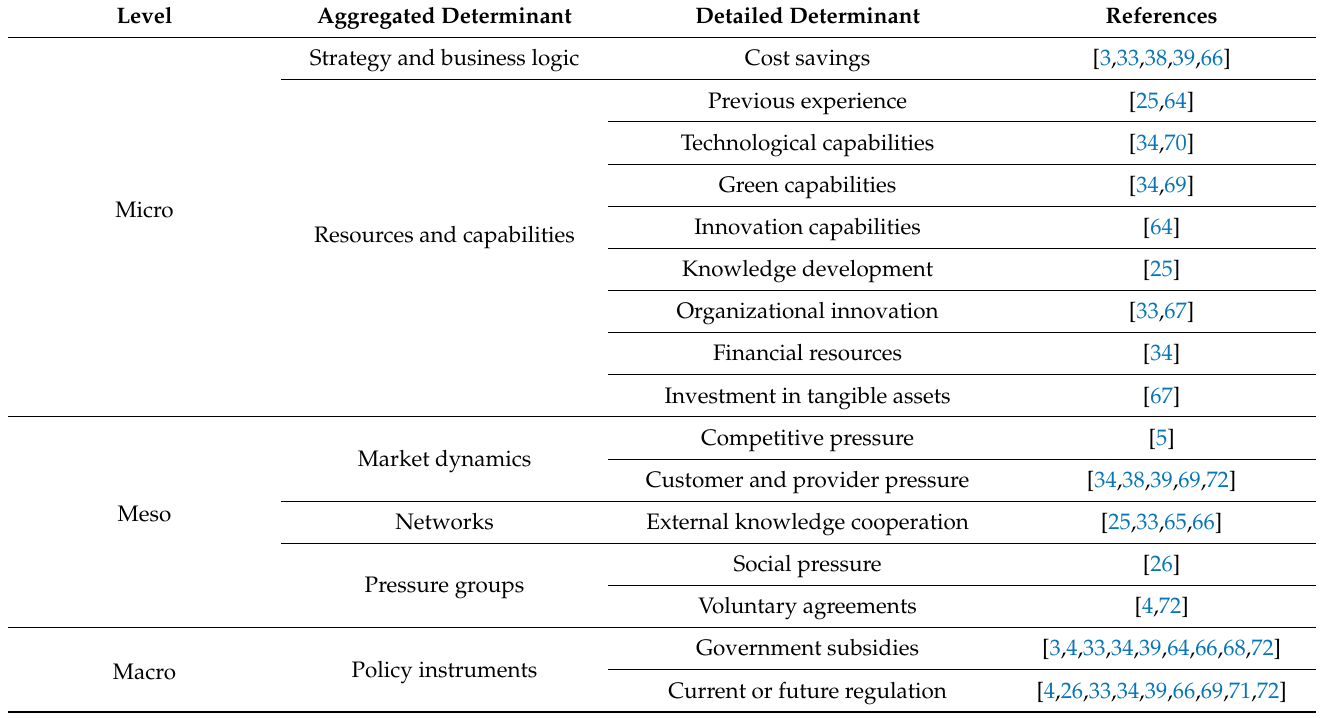
Table 4. Determinants of energy efficient